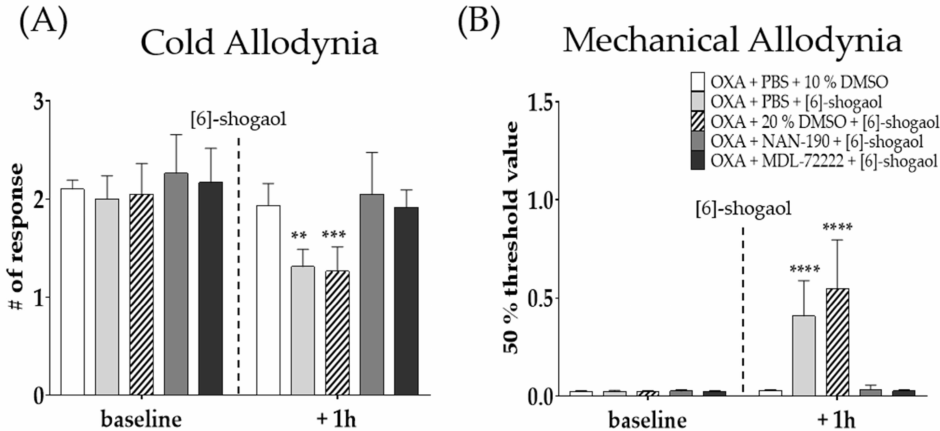
Figure 3. Effect of intrathecal injection of NAN-190 and MDL-72222 on the analgesic effect of [6]- shogaol on oxaliplatin-induced cold ( A ) and mechanical ( B ) allodynia. NAN-190 and MDL-72222 are 5-HT 1A and 5-HT 3 receptor antagonists, respectively. Cold allodynia was assessed by using acetone drop test ( A ) and mechanical allodynia was measured by using von Frey filament test ( B ). All groups received oxaliplatin injection four days prior to behavior tests. PBS and 20% DMSO was used as control for NAN-190 and MDL-72222, respectively. Ten percent DMSO or [6]-shogaol was intraperitoneal injected 20 min after intrathecal injection of PBS, 20% DMSO, NAN-190, and MDL- 72222. Baseline: before injection of PBS, 10%, and 20% DMSO, NAN-190, MDL-72222, and [6]-shogaol. + 1h: 1 h after injection of PBS, 10 and 20% DMSO, NAN-190, MDL-72222, and [6]-shogaol. Data are presented by mean ± SEM. OXA + PBS + 10% DMSO: n = 5, OXA + PBS + [6]-shogaol: n = 7, OXA + 20% DMSO + [6]-shogaol: n = 7, OXA + NAN-190 + [6]-shogaol: n = 7, OXA + MDL-72222 + [6]-shogaol: n = 6. ** p < 0.01, *** p < 0.001, ****, p < 0.0001 vs. Control with two-way ANOVA followed by Tukey’s multiple comparisons